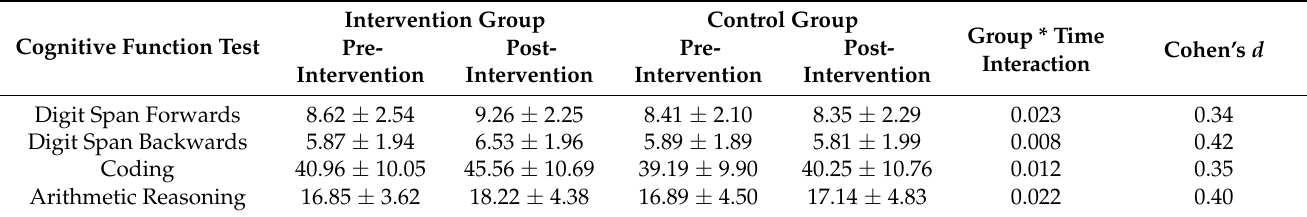
Table 2. Cognitive function data, pre- and post- intervention, in the intervention and control groups. Data are mean ± SD.